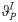
Hebbian learning with homeostatic MPDP on inhibitory synapses.A conductance based integrate-and-fire neuron is repeatedly presented with a fixed input pattern of activity in presynaptic inhibitory or excitatory neuron populations (top row—blue dots are excitatory, red dots are inhibitory spike times). The number of input neurons is Ni = 142 for the inhibitory population and Ne = 571 for the excitatory population. Second row shows the membrane potential before learning. The upper red line is the threshold for potentation of inhibitory synapses ϑPI, lower red line is resting potential and threshold for depression ϑDI. The third row shows the voltage as before with added teacher input by an additional population of excitatory neurons; this input induces a spike at t = 100ms. The fourth row shows the voltage after 100 learning steps with MPDP on inhibitory synapses only, with teacher input, the next row shows the recall without teacher. The spike is almost at the same position in the recall case. The last row shows the voltage after 1000 recall trials during which the inhibitory synapses were allowed to change under the MPDP rule. Despite this, the output spike is still close to the desired time, which shows that the output is approximately stable.